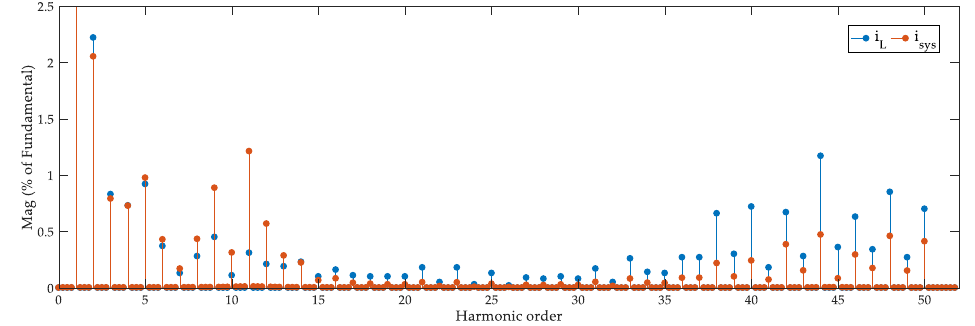
Figure 13. Waveforms and fast Fourier transform (FFT) spectrum of i L and i sys .